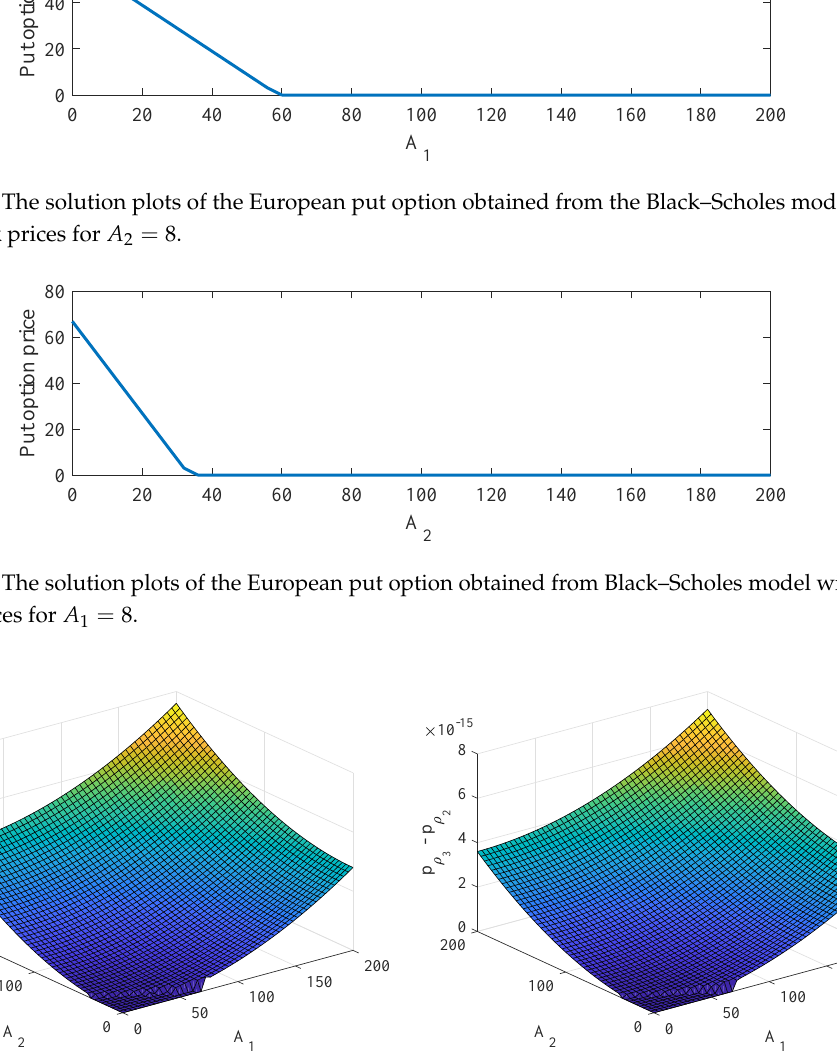
Figure 4. The different values of the European put option: ( a ) p ρ T with stock prices A 1 , A 2 and correlations ρ 1 = − 0.8, ρ 2 = 0 and ρ 3 =